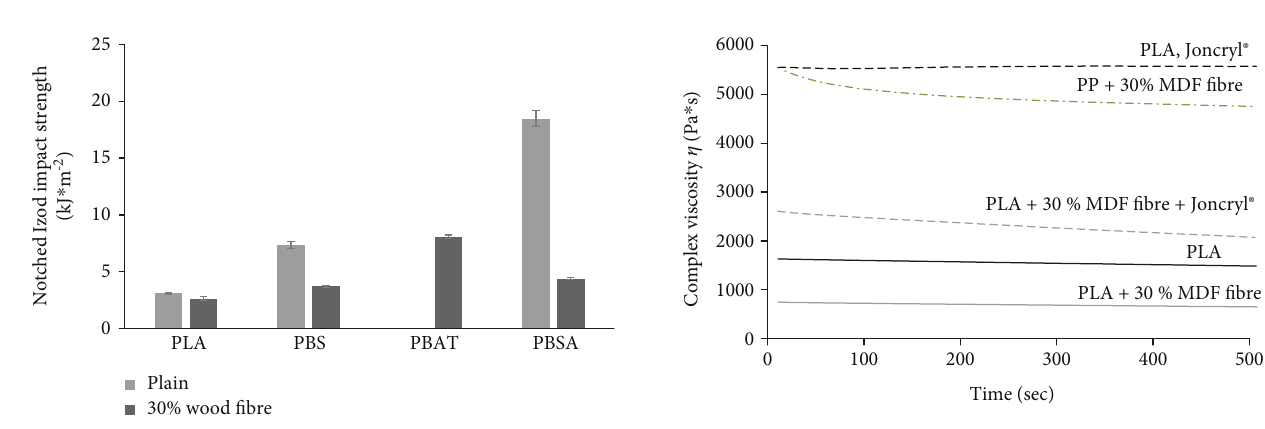
Figure 2: Impact strength of 4 biopolyesters, plain and fi lled with 30wt % MDF fi bre (error bars = ± 95% con fi dence interval) ( n = 10 ).